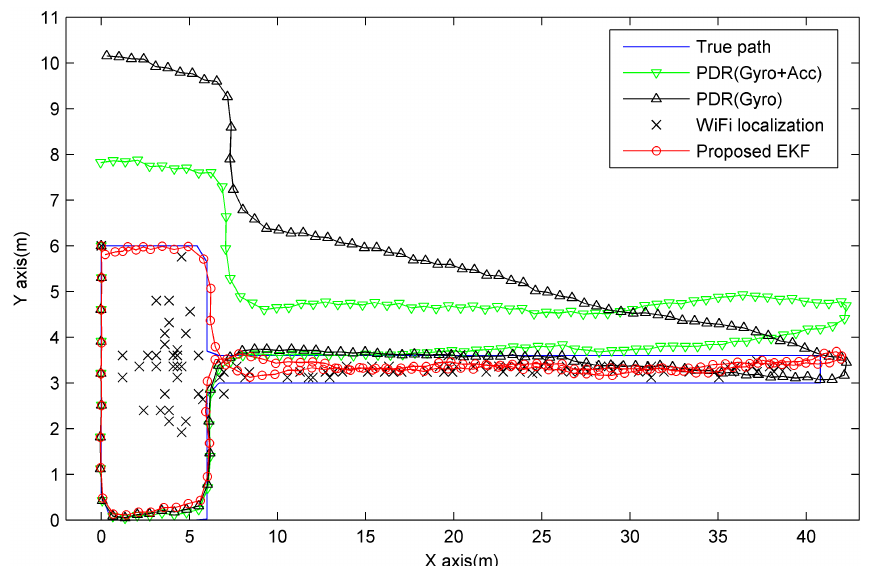
Figure 7. Comparisons between the true path, trajectories of PDR using gyroscope only, PDR with Gyro + Acc, WiFi localization and the proposed EKF based fusion